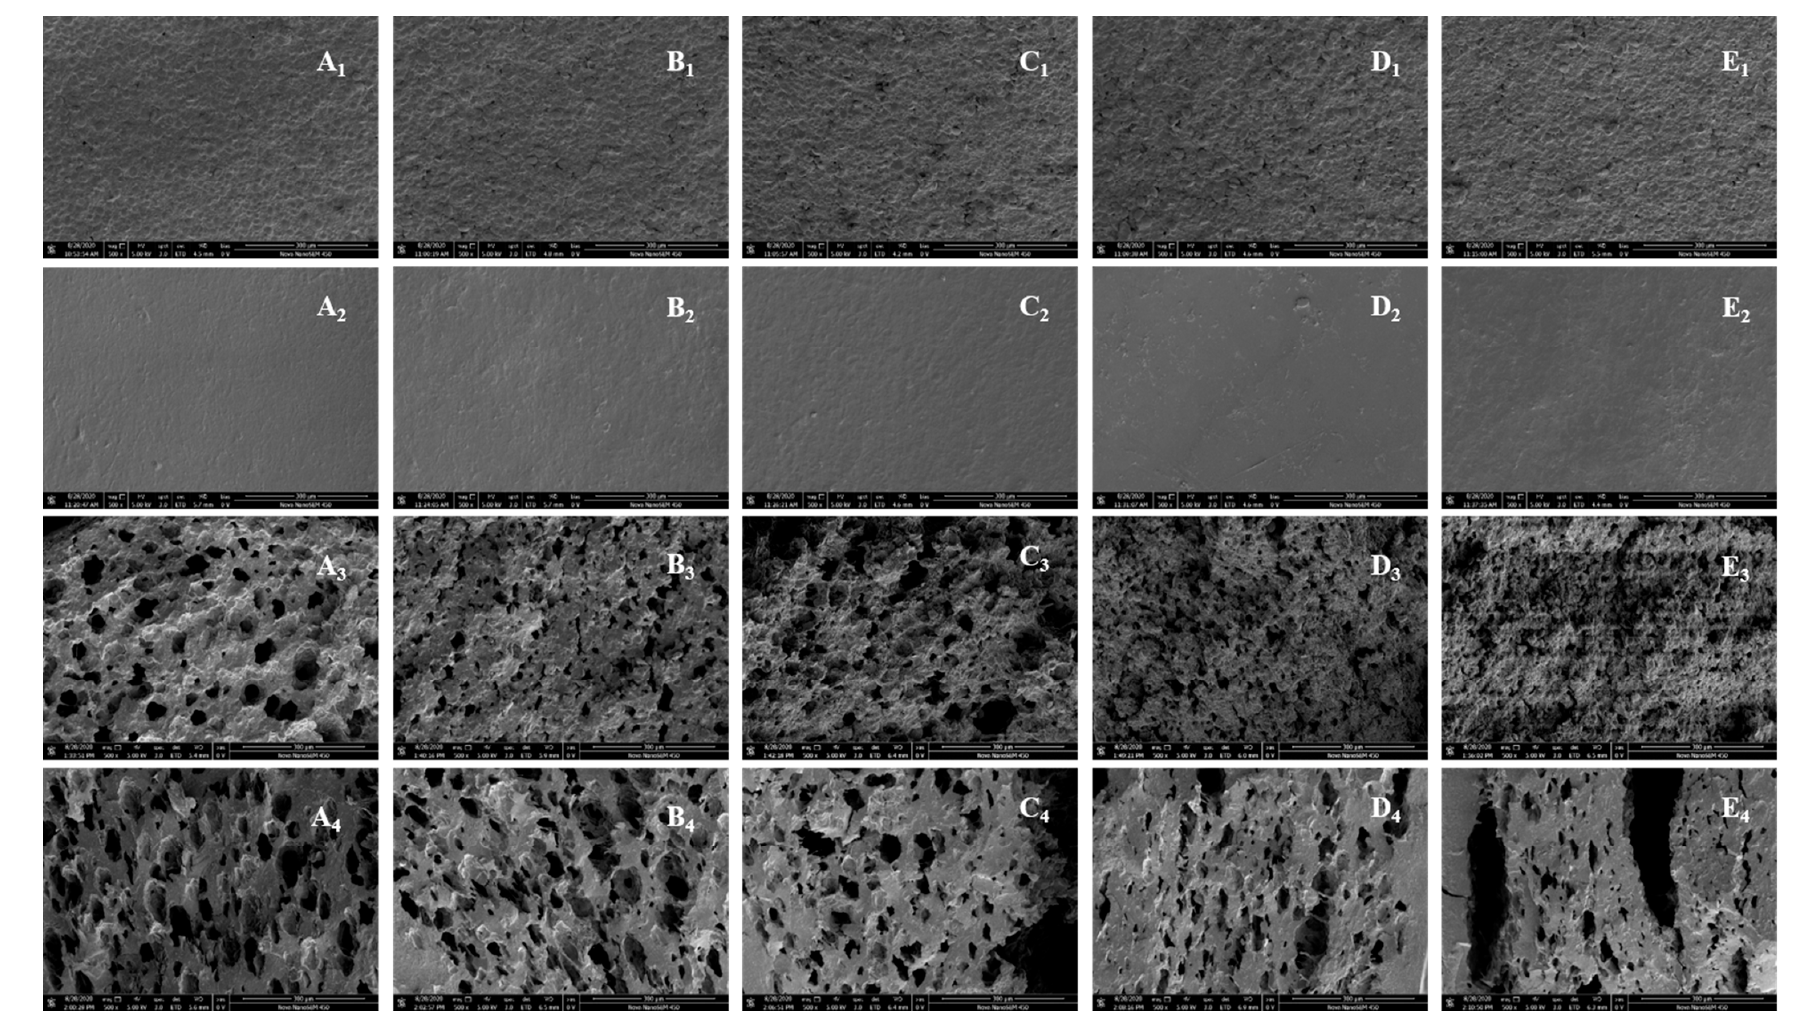
Figure 3. Scanning electron micrographs (SEM) (×500) of the surface and cross-section of noodles with different proportions of acorn flour (( A ) 0%; ( B ) 10%; ( C ) 15%; ( D ) 20%; ( E ) 25%; ( 1 ) the surface of raw noodles; ( 2 ) the surface of cooked noodles; ( 3 ) Cross-section of raw noodles; ( 4 ) Cross-section of cooked noodles.